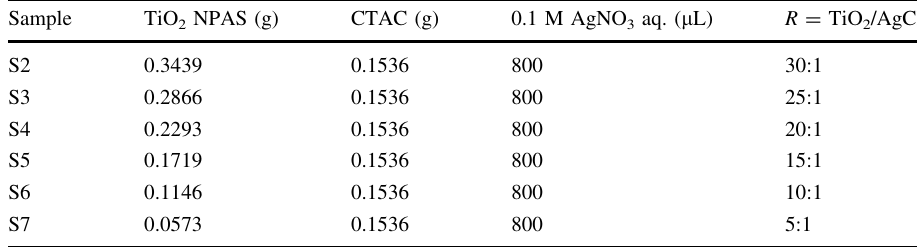
Table 2 Experimental condition for the preparation of different Ag–AgBr@TiO 2 NPAS samples